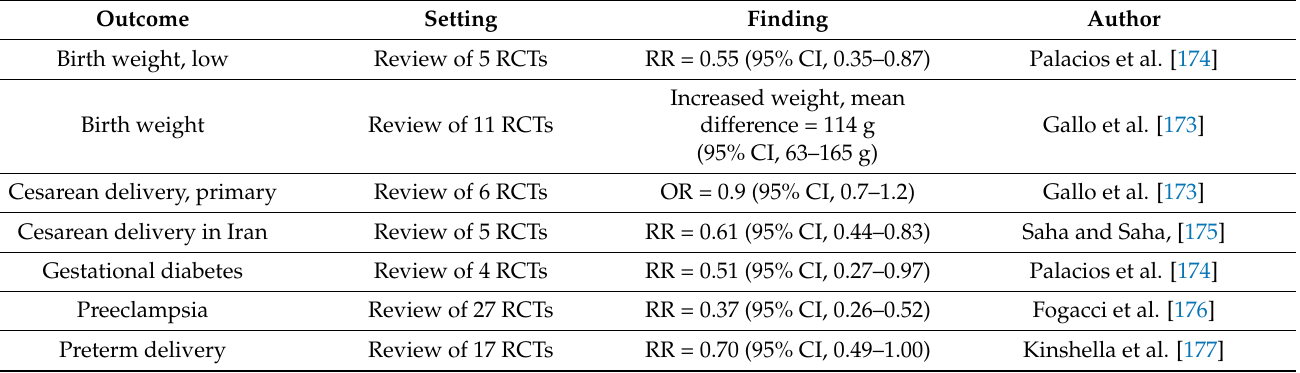
Table 5. Meta-analyses of vitamin D supplementation RCTs, comparing vitamin D supplementation with